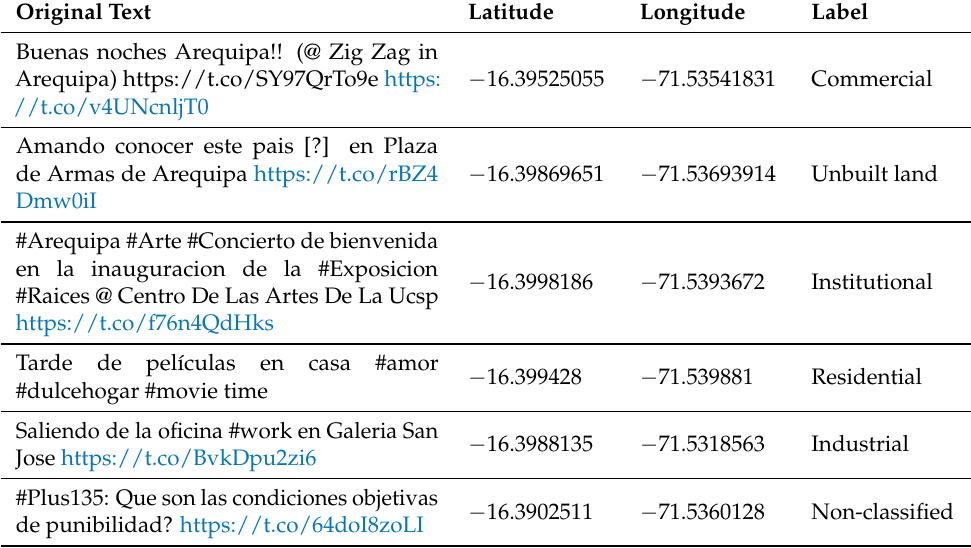
Table 8. Classification results with real